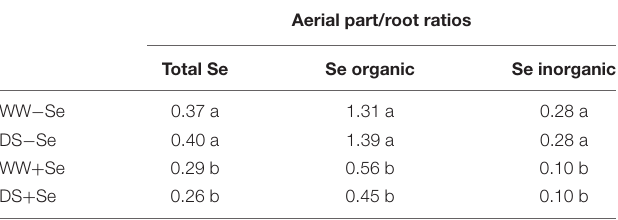
Aerial part/root ratios Total Se Se